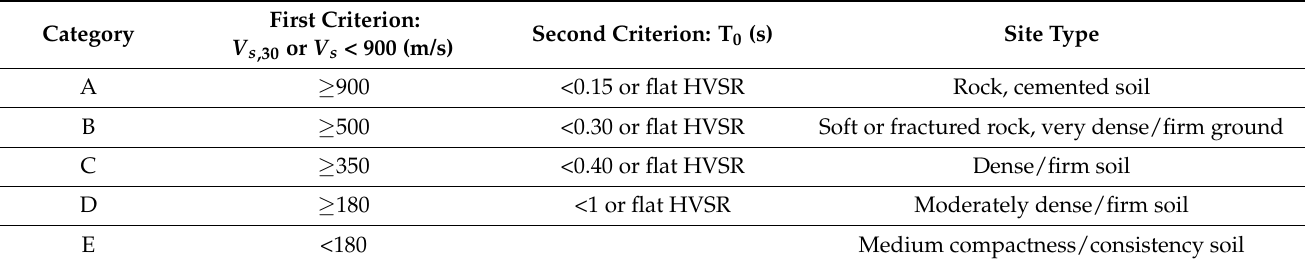
Table 1. Seismic classification (modified from Verdugo et al.